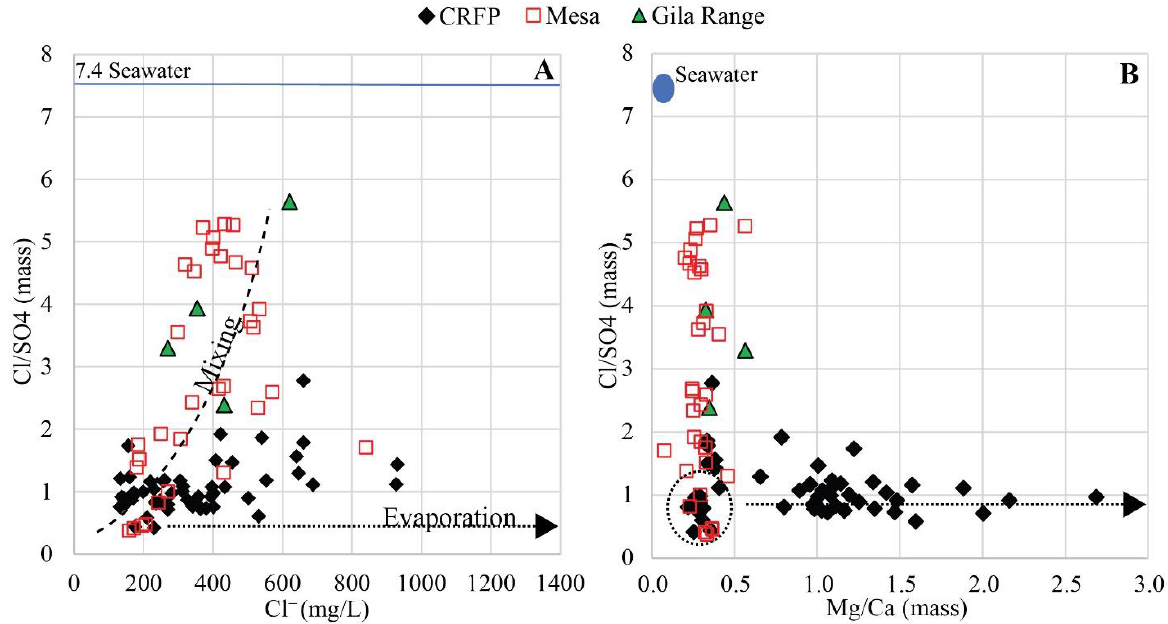
Figure 14. ( A ) Cl − (mg/L) vs. Cl − /SO 42- (mass ratio) values for floodplain (CRFP), Yuma–San Luis Mesas (Mesa), and Gila Range. The dashed line represents a hypothetical mixing trend. The dotted line represents the potential evaporation trajectory. ( B ) Mg/Ca vs. Cl − /SO 42- (mass ratio) values for floodplain (CRFP), Mesa, and Gila Range samples. The dashed line represents potential evaporation trajectories. Solid blue lines show ratios of seawater in A and B [56]. The Mg/Ca mass ratio for the Gila Range samples varies between 0 and 0.6 (Figure